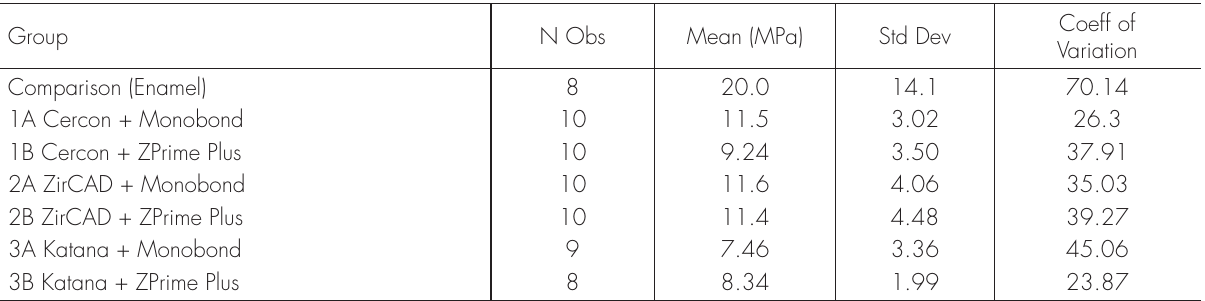
Table II. Shear bond strength.